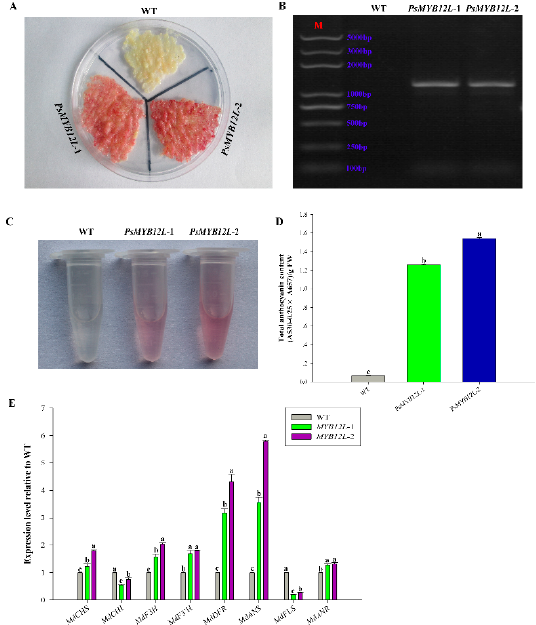
Figure 8. Overexpression analysis of the PsMYB12L gene in apple calli. ( A ) Colors observed in transgenic apple calli and the WT. ( B ) Results of positive PCR detection in transgenic apple calli. ( C ) Anthocyanin extraction solutions for transgenic apple calli and the WT. ( D ) Total anthocyanin content in transgenic apple calli and the WT. ( E ) Expression analysis of anthocyanin biosynthesis-related genes in transgenic apple calli and the WT. PsMYB12L -1 and PsMYB12L -2, two transgenic lines of the PsMYB12L gene. Different lowercase letters indicate significant differences at P < 0.05. Additionally, the expression levels of anthocyanin biosynthesis-related genes ( MdCHS , MdCHI , MdF3H , MdF3 ′ H , MdDFR , MdANS , MdFLS , and MdANR ) in the WT and the transgenic lines of PsMYB114L and PsMYB12L were analyzed by qRT-PCR. Compared with the WT, overexpression of PsMYB114L downregulated the expression of most of the genes, specifically, MdCHS , MdCHI , MdF3H , MdF3 ′ H , MdFLS , and MdANR , and upregulated the expression of MdDFR and MdANS in transgenic PsMYB114L calli (Figure 7E). For PsMYB12L overexpression, the expression levels of most genes, including MdCHS , MdF3H , MdF3 ′ H , MdDFR , MdANS , and MdANR , were upregulated, but those of MdCHI and MdFLS were downregulated in transgenic PsMYB12L calli (Figure 8E). 3. Discussion Flower color is a very important trait in many ornamental plants and has a close association with their ornamental and commercial value. Many prior studies have shown that anthocyanins are a key factor influencing flower color [43–45]. R2R3-MYB TFs comprise one of the largest gene families in plants and play key roles in regulating anthocyanin accumulation by activating the expression of structural genes involved in the anthocyanin biosynthetic pathway [46,47]. However, the role of R2R3-MYB TFs in regulating flower color in P. suffruticosa has seldom been functionally verified. Therefore, determining how certain R2R3-MYB TFs regulate anthocyanin production in P. suffruticosa would aid in breeding improved cultivars with desirable flower colors.